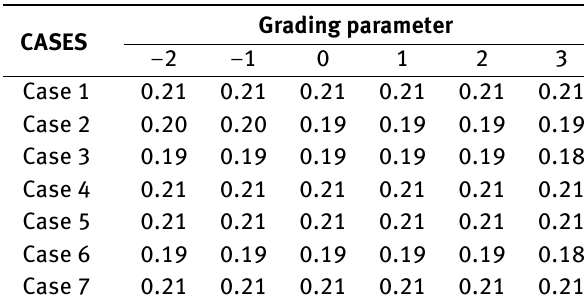
Figure 43: Radially distributed radial stress